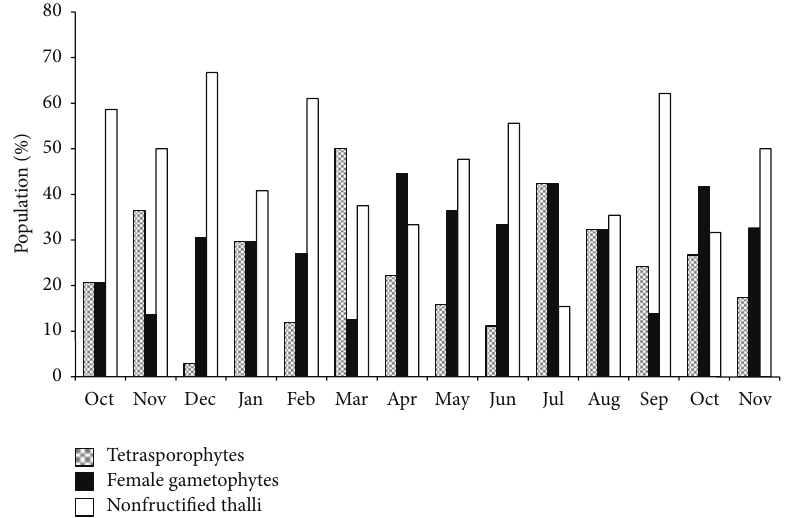
Figure 3: Population structure of C hondrus crispus in Buarcos bay.